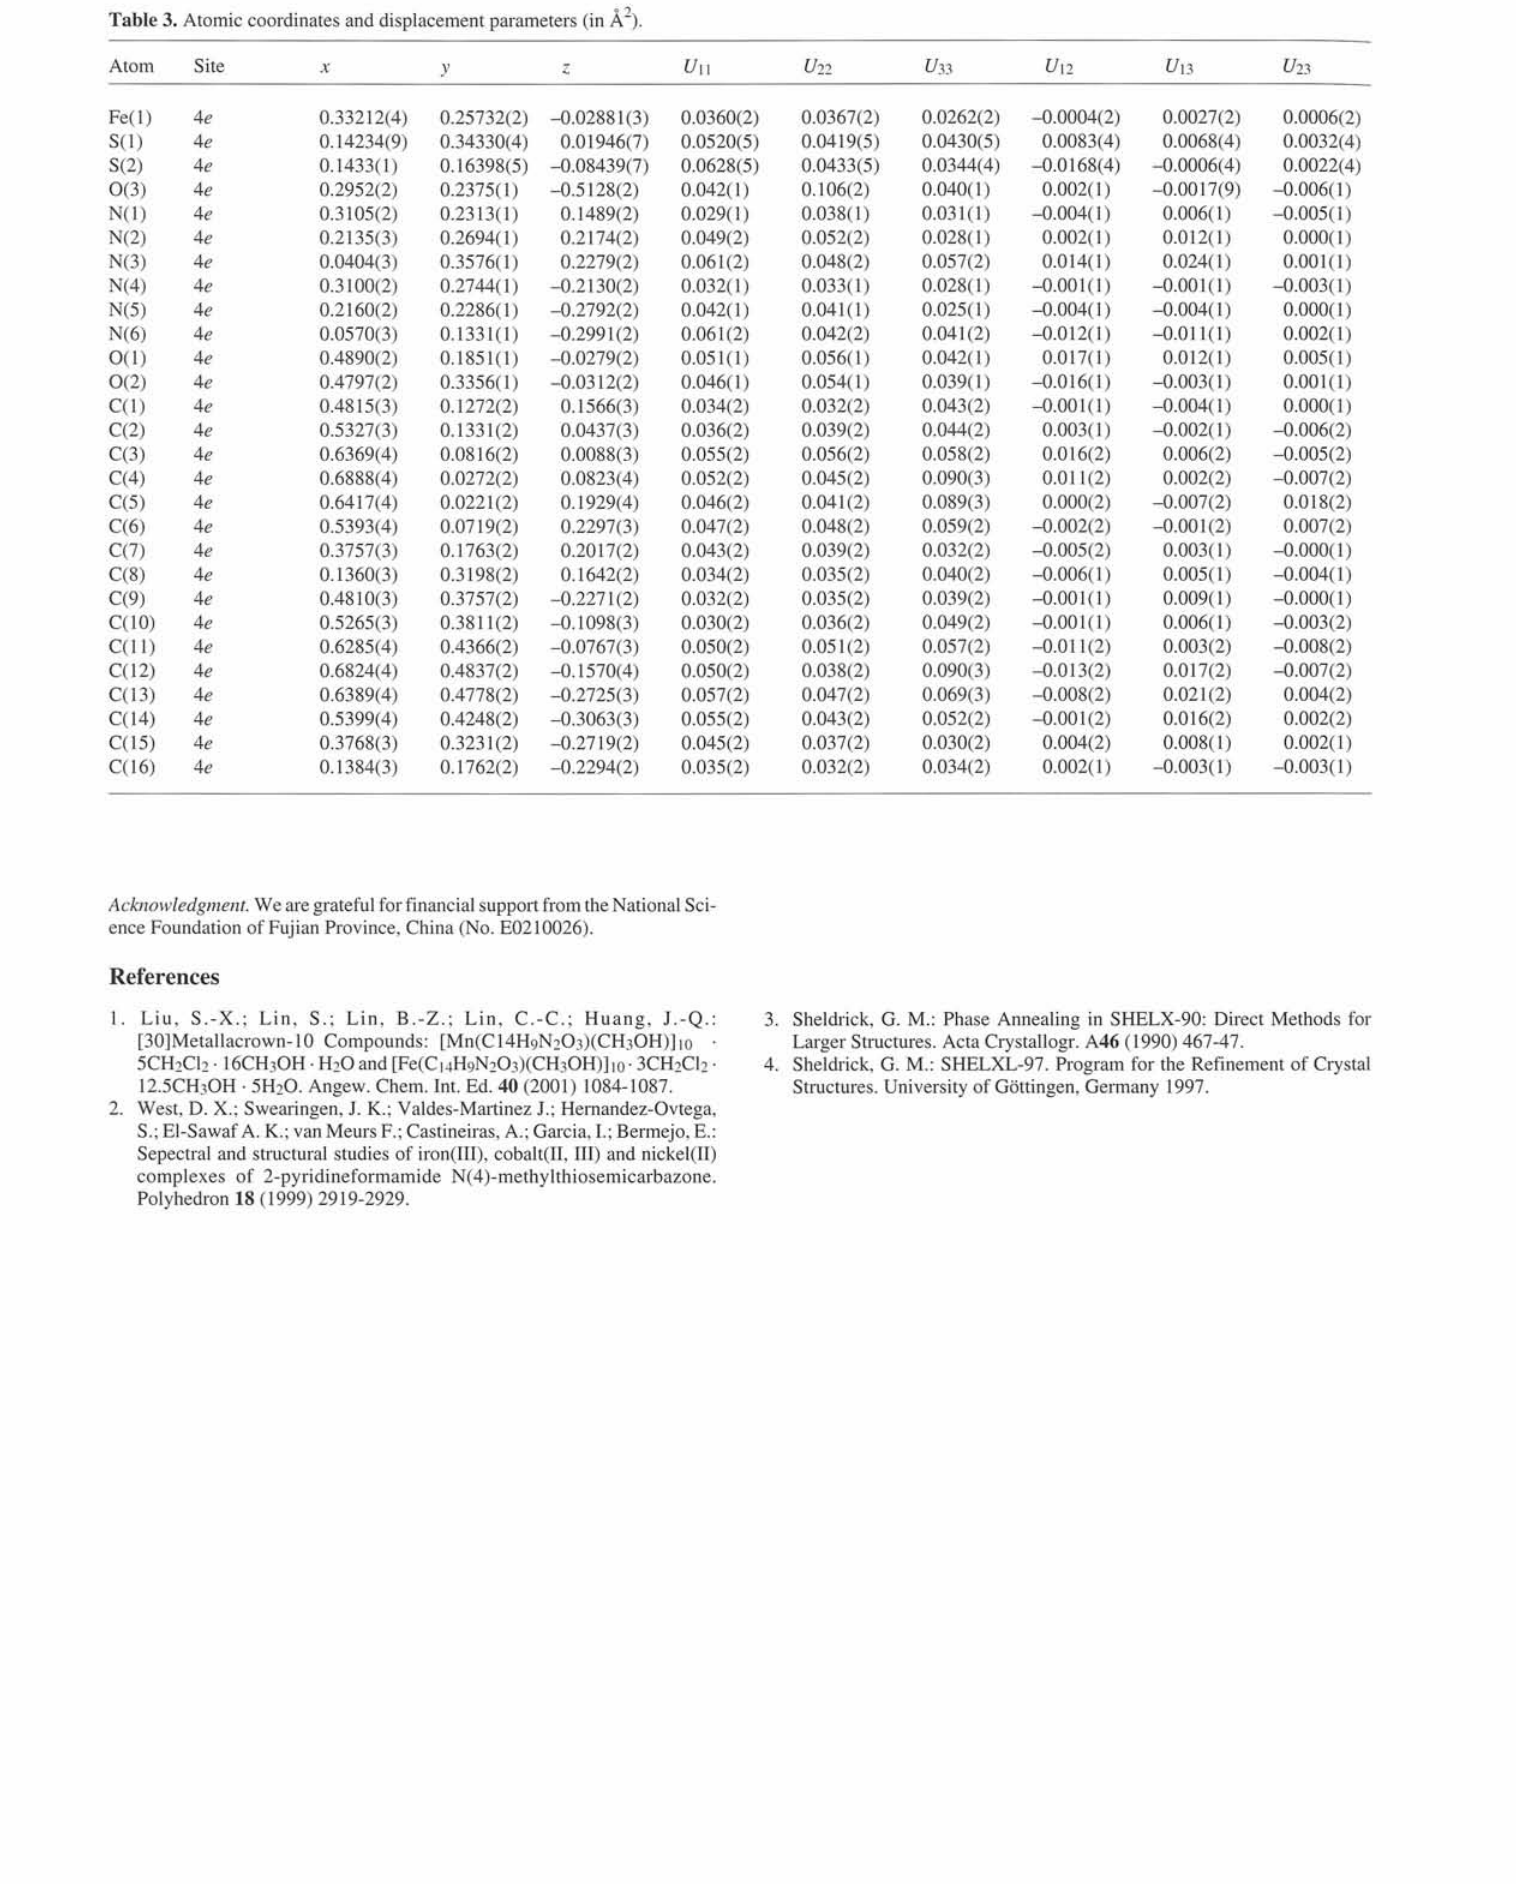
Table 3. Atomic coordinates and displacement parameters (in Â 2